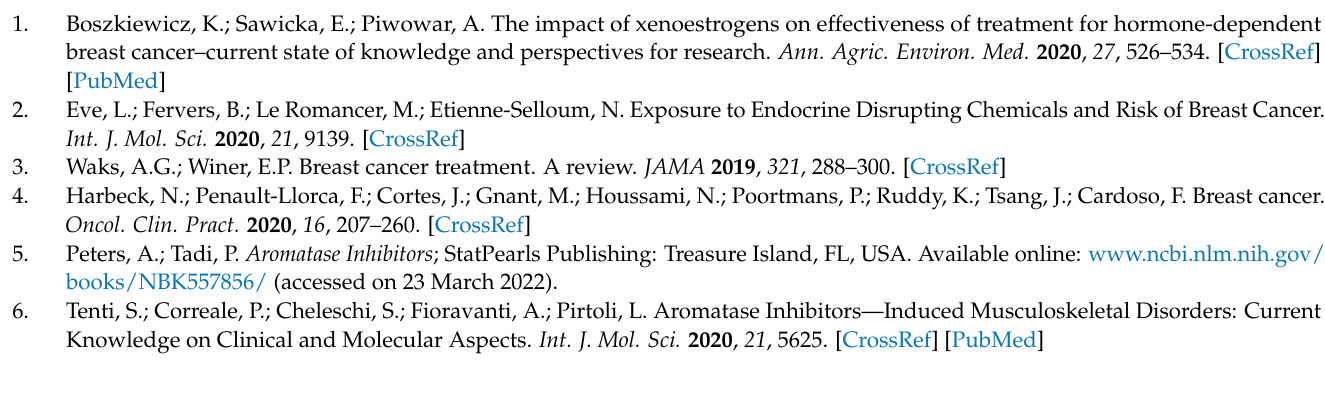
plementary Table S2: Quality assessment of included studies. Supplementary Material S1: sensitivity analysis. Supplementary Material S2: additional analysis early vs. advanced/metastatic breast